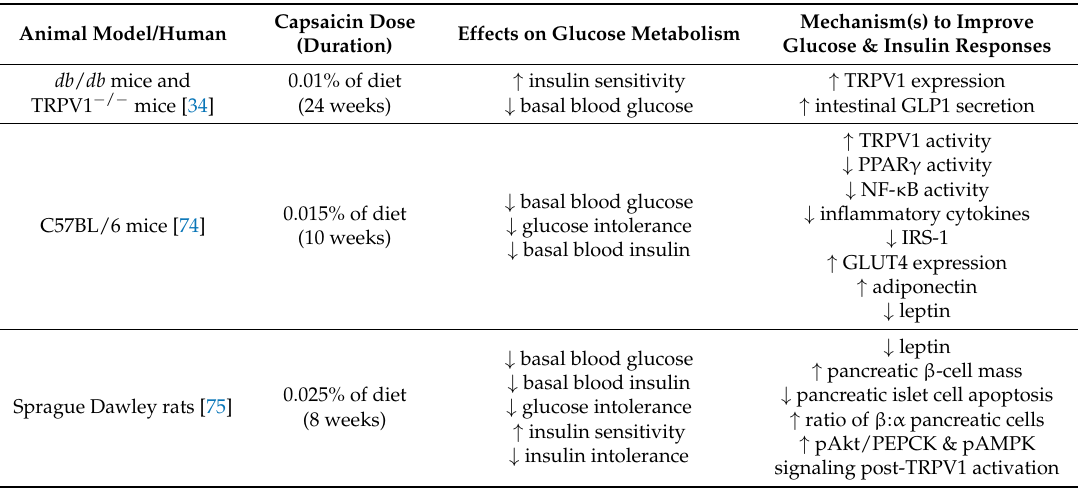
Table 1. A summary of key studies demonstrating the effect of capsaicin on glucose metabolism and insulin responses in animal models and